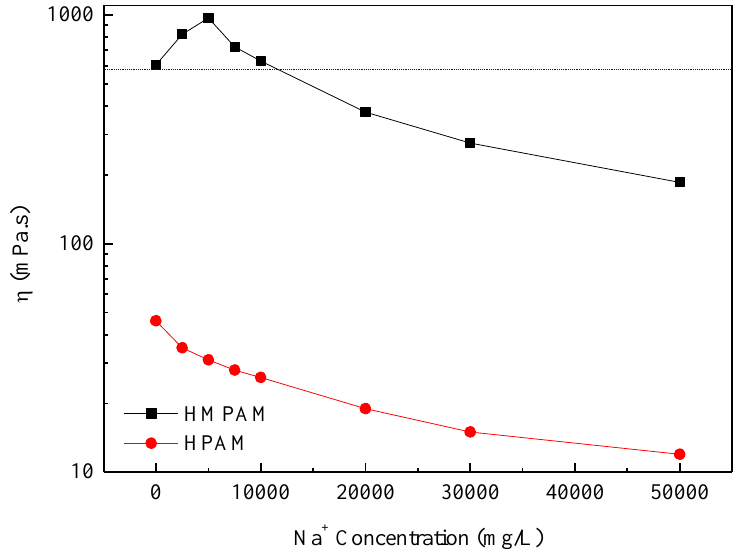
Figure 2. The apparent viscosity of polymer solutions with 1500 mg/L versus Na + concentration at 45 °C. HMPAM — hydrophobically modified polyacrylamides; HPAM — hydrolyzed polyacrylamide.